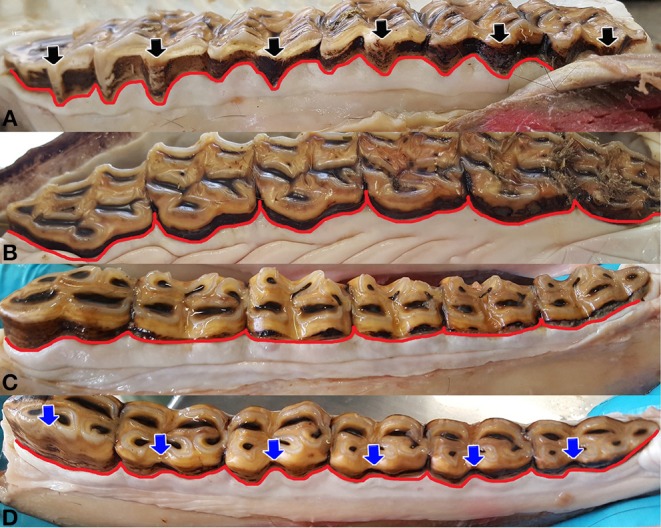
Shape and contour of the gingival margin (red line). The regularly double-waved contour of the buccal aspect of the upper jaw (A), is composed of the pre- and post-mesostyle papilla, enclosing the mesostyle (black arrow). Interdental papilla can be seen irregularly. The palatal aspect of the upper jaw (B) shows a slightly undulatory single-waved contour, which can feature a marked interdental papilla. Shape and contour of the gingival margin, buccally (C) and lingually (D), in the lower jaw, is almost straight. In teeth, with a pronounced linguaflexid (blue arrow), a dental papilla was additionally visible.